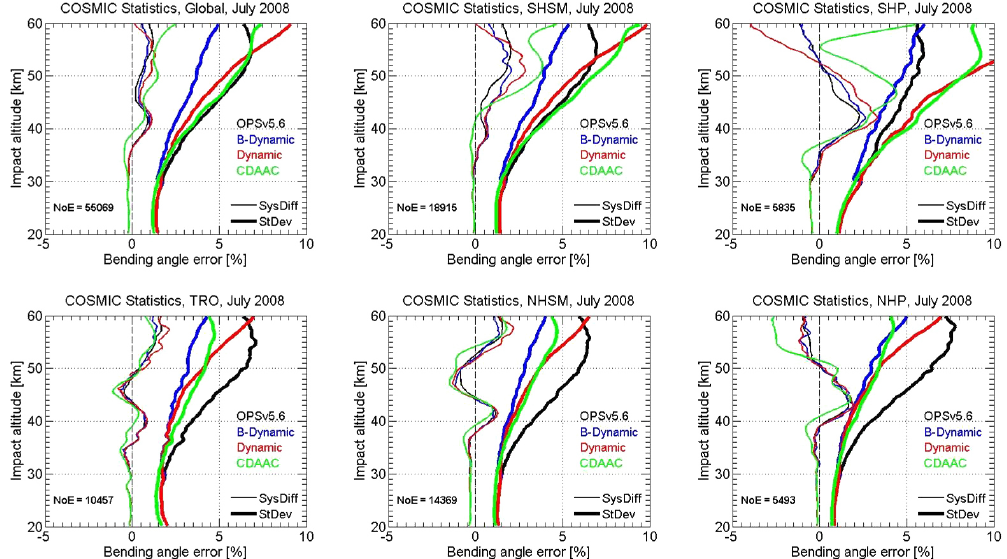
Figure 12. Systematic differences (SysDiff, light lines) and standard deviations (SD, heavy lines) of statistically optimized bending angles, relative to co-located ECMWF analysis bending angles used as a reference, of COSMIC events from July 2008. Statistics for the OPSv5.6 (black), b-dynamic (blue), dynamic (red), and CDAAC (version 2010.2640, green) statistical optimization algorithms are shown for the same six regions as in Fig. 10. The figure layout is the same as for Figs. 10 and